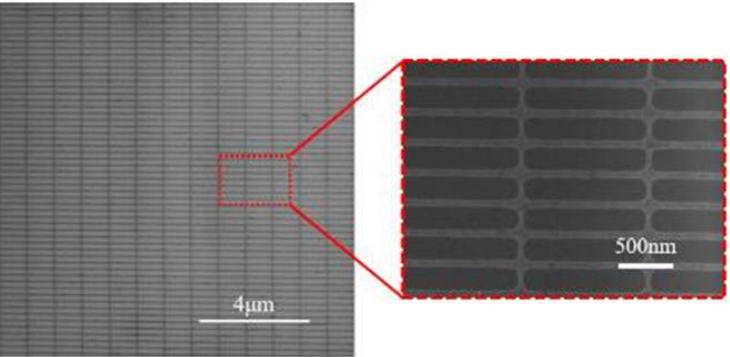
Figure 7. SEM images of the graphene nanomesh structure after oxygen plasma etching.